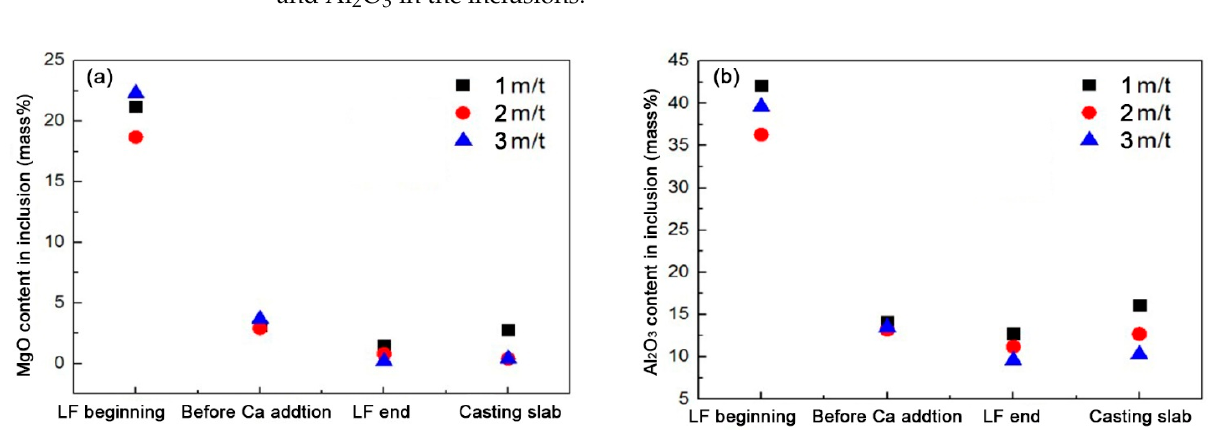
Figure 10. Influence of Si-Ca addition amount on MgO and Al 2 O 3 contents of inclusions at different stages. ( a ) MgO content, ( b ) Al 2 O 3 content.